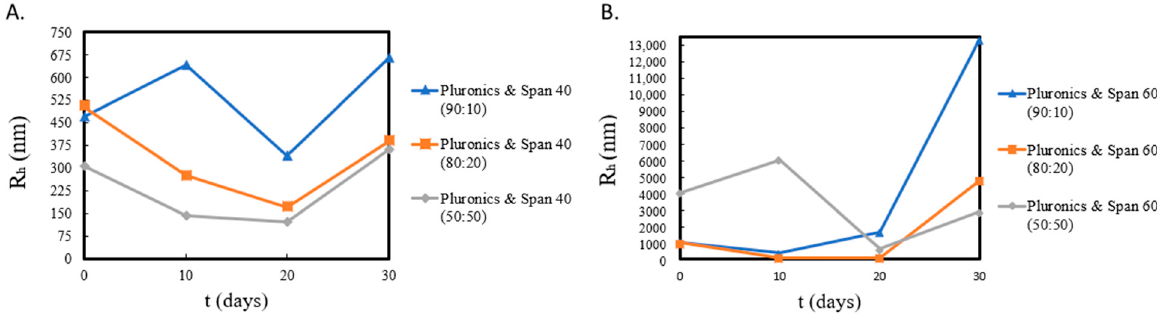
Figure 2. Stability assessment of ( A ) Poloxamer-Span 40 ® and ( B ) Poloxamer-Span 60 ® formulations through R h measurements over time from day of preparation.